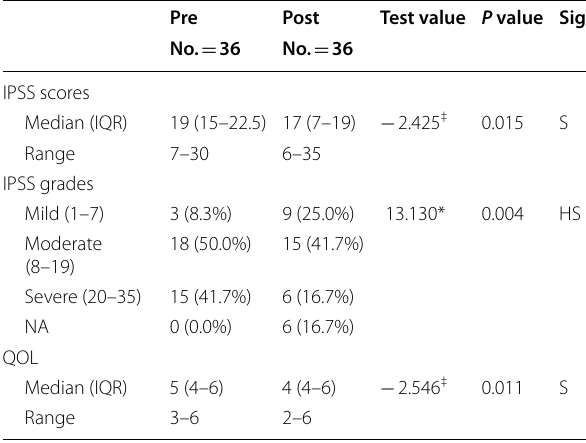
Table 1 Demonstrates the statistical significance of IPSS and QoL changes post